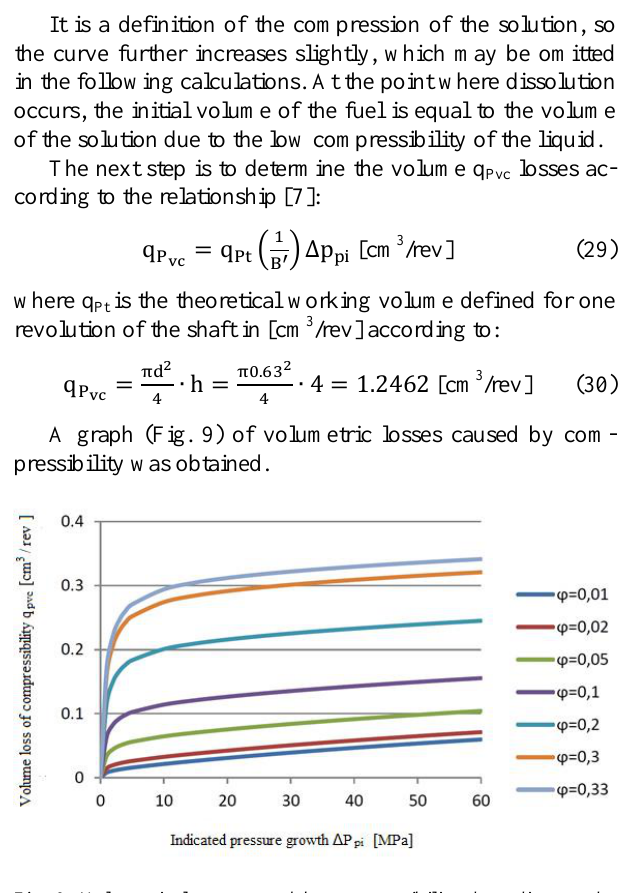
Fig. 9. Volumetric losses caused by compressibility depending on the indicated pressure of the pump, where φ > 0 means diesel fuel with gas in certain ratios, φ = 0.33 determines the volume ratio for the example of a hypocycloidal